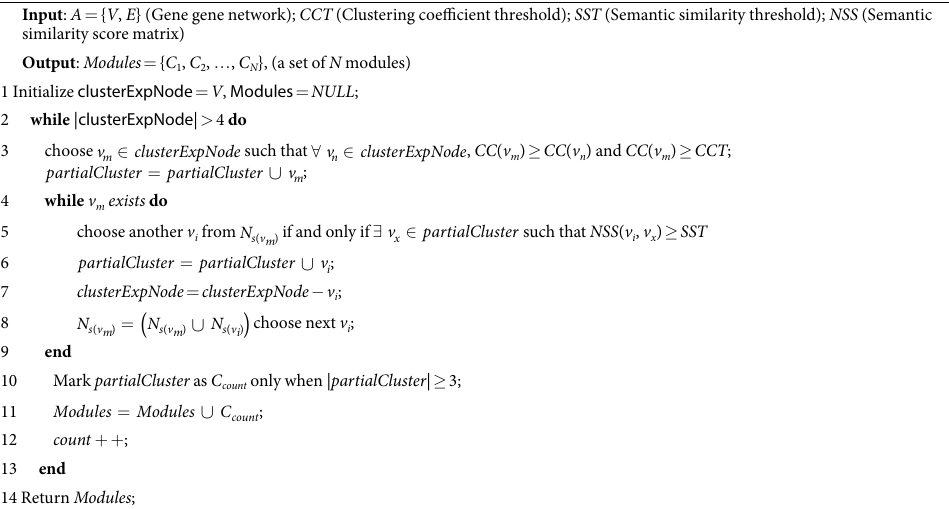
Algorithm 1: Algorithm for module extraction from gene gene